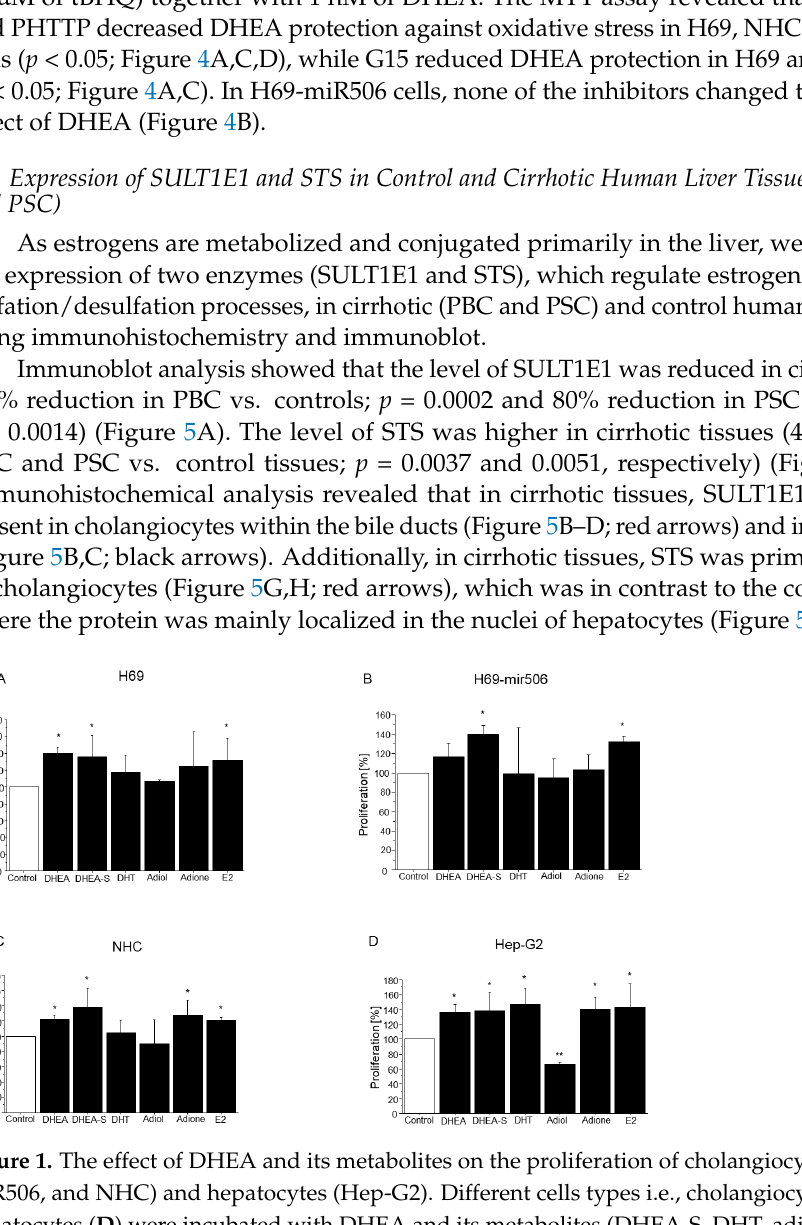
Figure 2. Effect of DHEA and its metabolites on the apoptosis induced by GCDC in cholangiocytes and hepatocytes. H69 ( A , B ), H69-mir506 ( C ), NHC ( D ) and Hep-G2 ( E ) cells were incubated with DHEA or its metabolites followed by GCDC. Twenty-four hours following treatment apoptosis was detected using an Annexin V/Propidium iodide (PI) kit. X-axis, Annexin V. Y-axis, PI fluorescence intensities. Representative figures show the population of viable (LL), early apoptotic (LR), late apoptotic (UR) and necrotic (UL) cells. Results are expressed as a percentage of early apoptotic cells